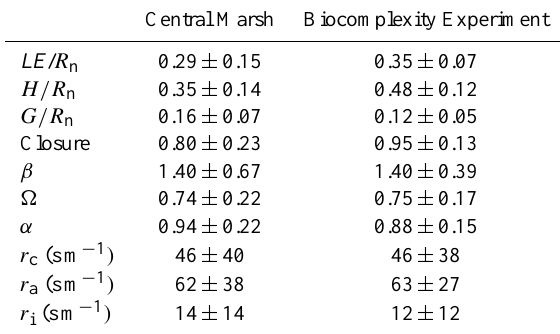
Table 3. Mean midday (12:00 through 16:00) energy balance parti- tioning and bulk parameters at the CM (1999–2003) and BE (2006– 2008) sites during the thawed season (through